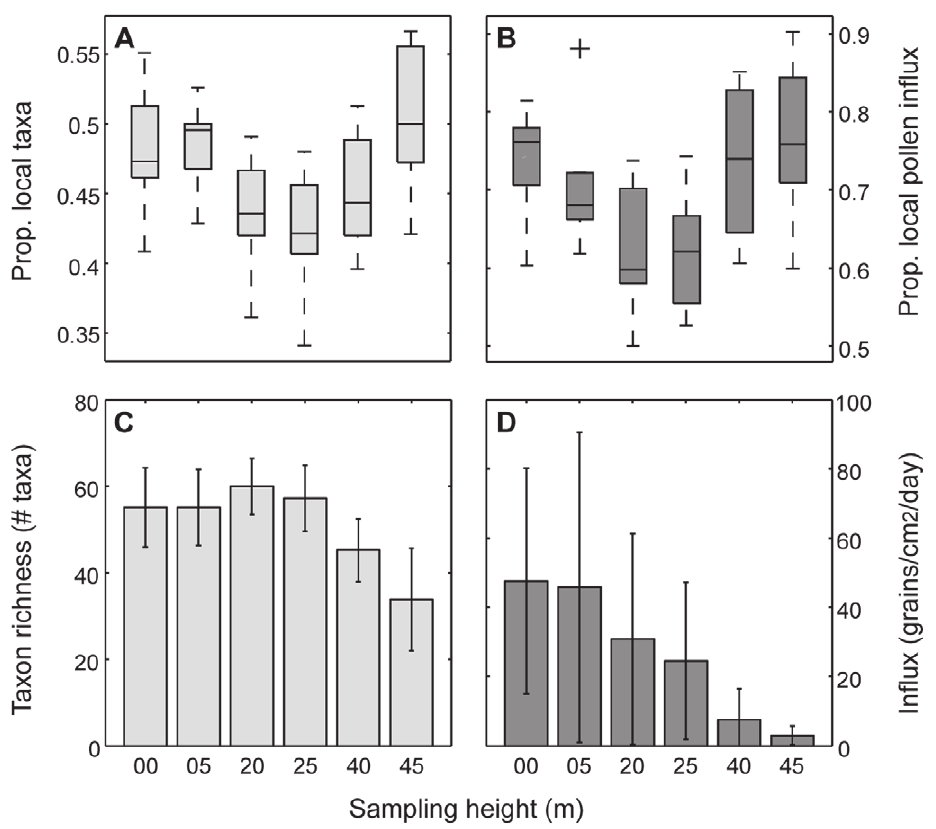
Figure 1. Contribution of local taxa to pollen assemblage richness and influx as a function of sampling height. Boxplots of proportion of pollen taxa in the ten annual aggregate samples that correspond to local species, those within 50 m of Lutz tower, are shown in (A) and the proportion of pollen influx that corresponds to local species, is shown in (B). Influx is measured as the number of grains/cm 2 /day. Median values are designated by horizontal bars. The edges of the box are the 25th and 75th percentiles. Whiskers represent + / 2 2 s or 95% of the data. Outliers are plotted as single points. The number of pollen taxa recorded at each height is shown in (C) and the annual pollen influx for each sampling height is shown in (D). Error bars for (C, D) represent one standard deviation.